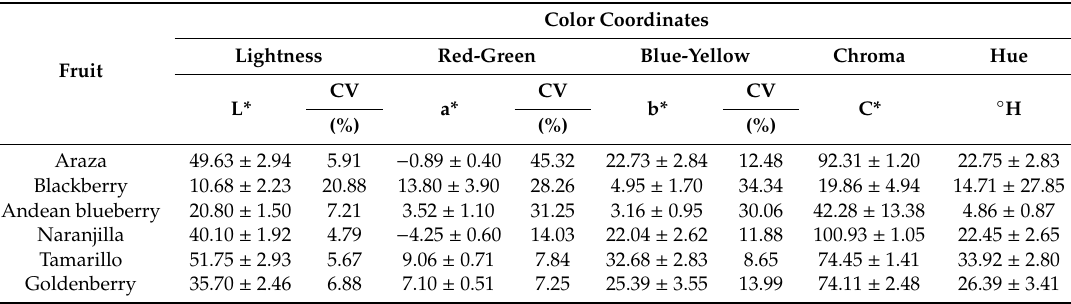
Table 3. CIE L*a*b* color coordinates in several tropical and Andean